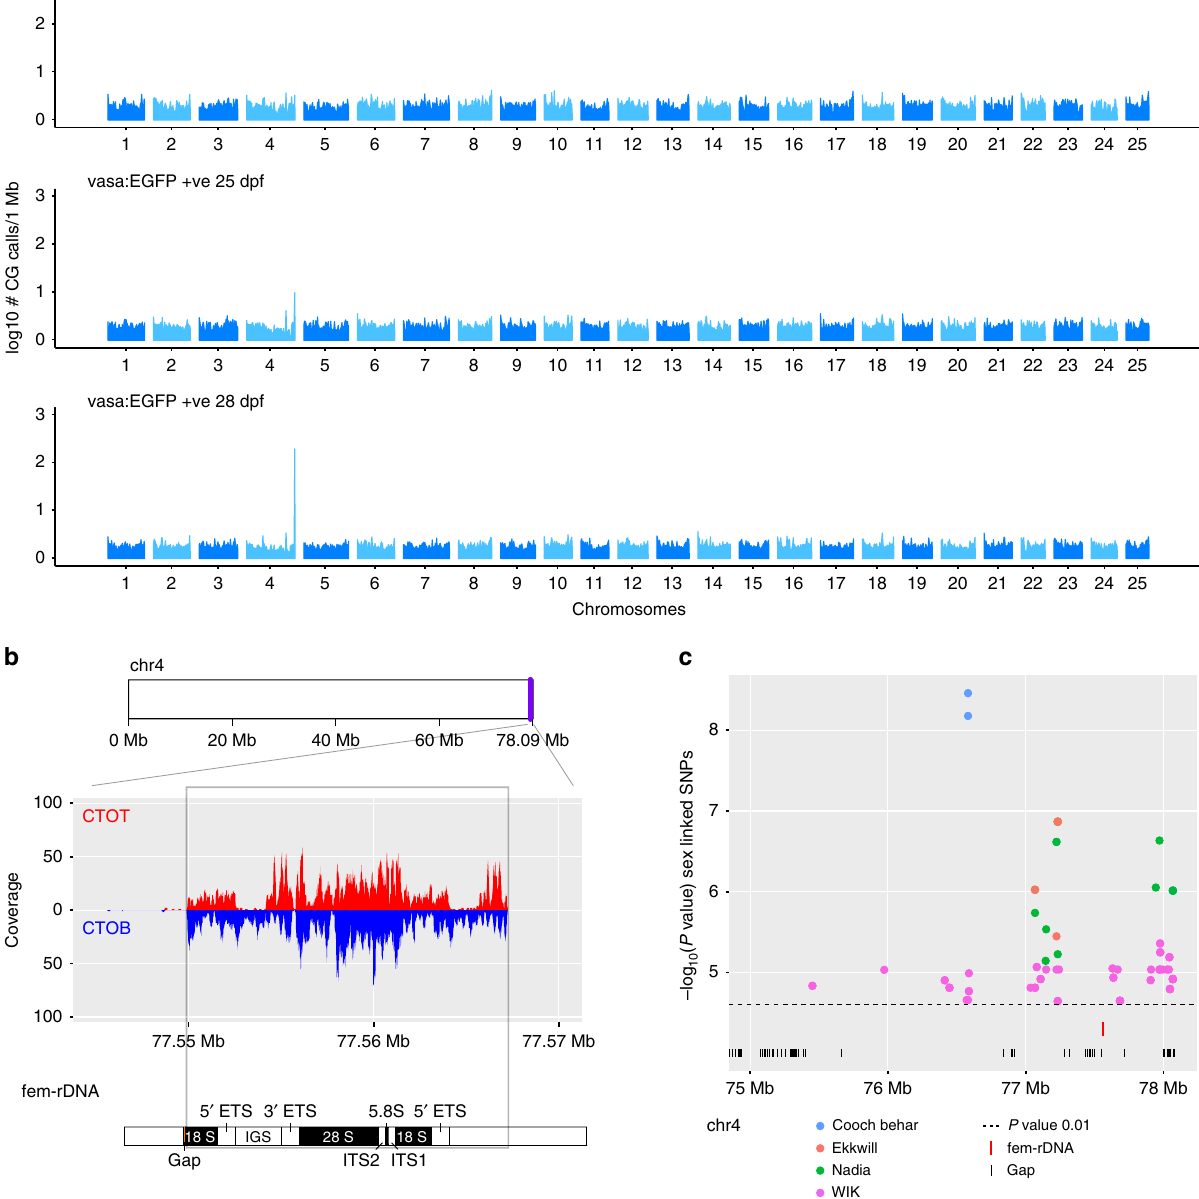
Fig. 3 Ampli fi cation of oocyte-speci fi c fem-rDNA in a previously identi fi ed sex-linked region. a Number of CG calls mapping to windows of 1 Mb in the whole zebra fi sh genome. A peak is observed at the right tip of chromosome 4 following 25-dpf and 28-dpf. b Reads map to both the complementary original top (CTOT, red) complementary original bottom (CTOB, blue) strand of the 45S fem-rDNA unit on chromosome 4. Components of the rDNA repeat are indicated (External transcribed spacer (ETS), Internal transcribed spacer (ITS), Intergenic spacer (IGS)). c The ampli fi ed region is located within the most signi fi cant sex-linked SNPs from non-domesticated zebra fi sh strains, Cooch Behar, Ekkwill, Nadia and